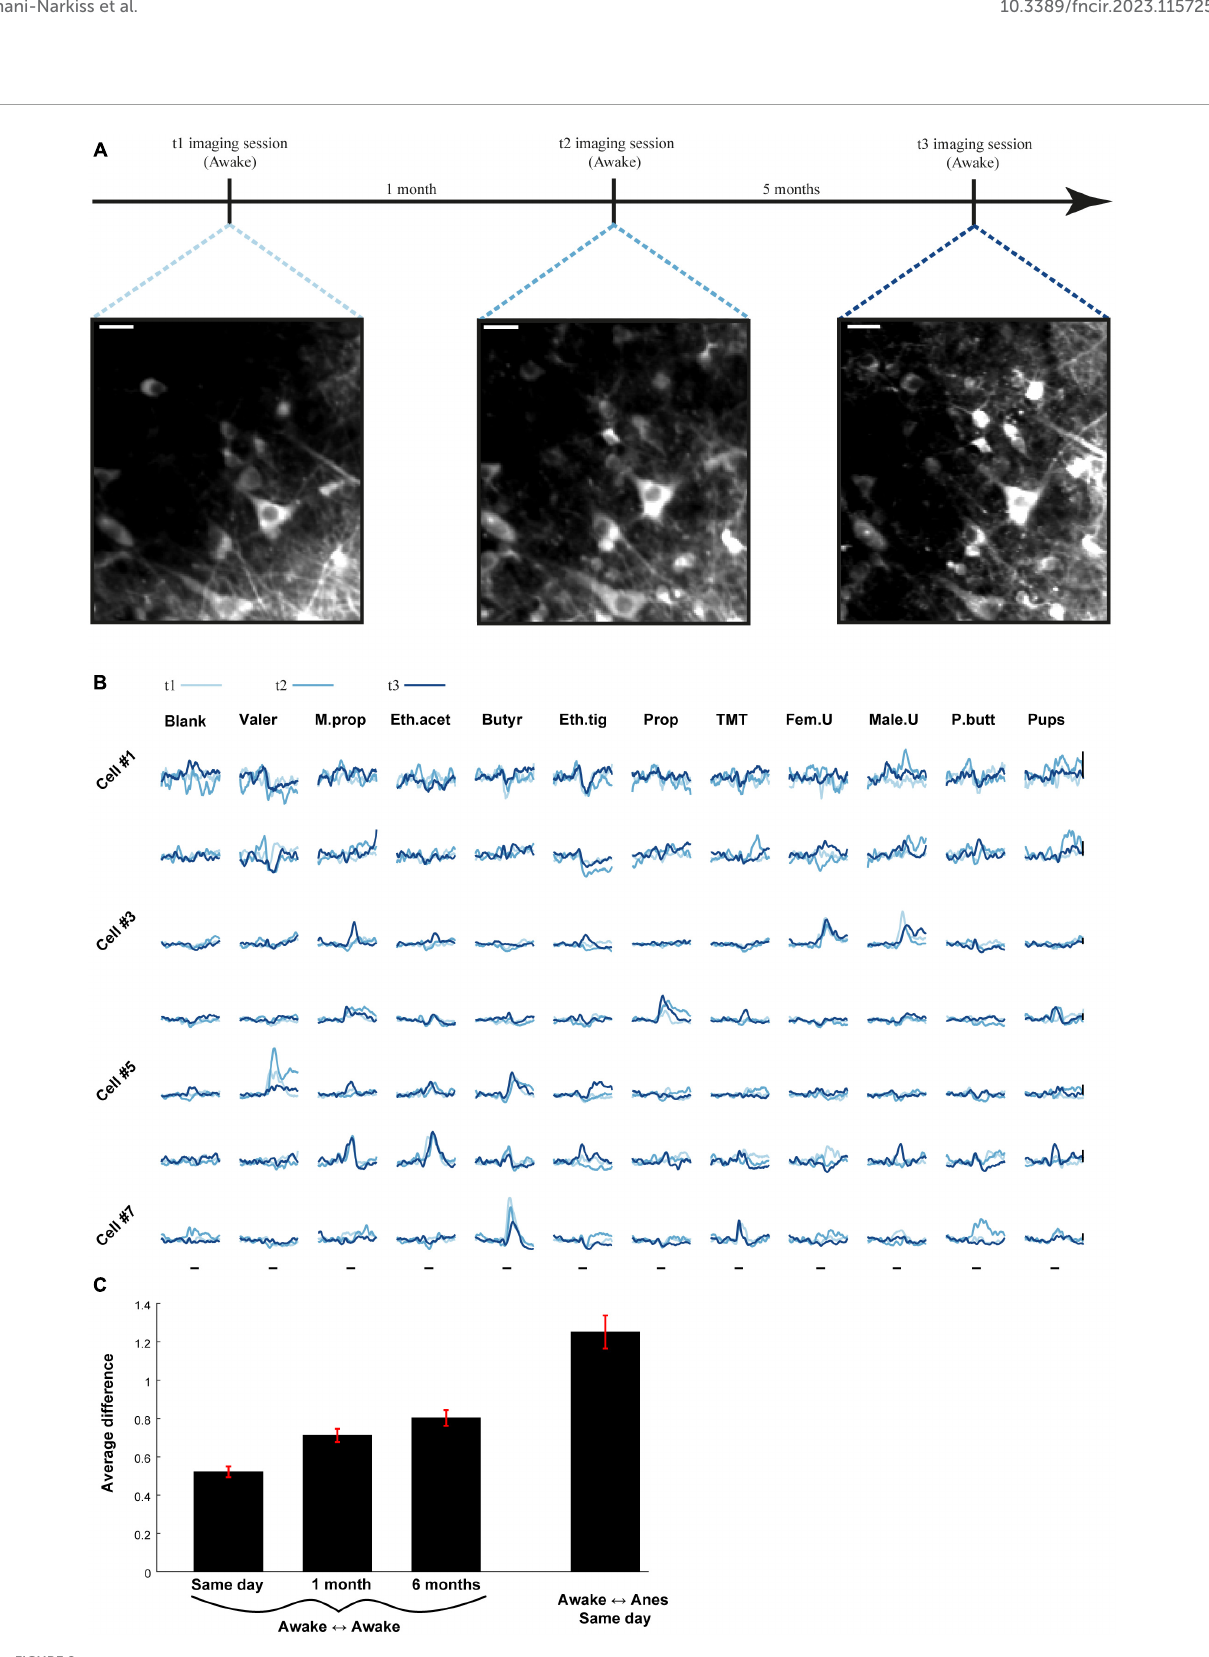
FIGURE8 Odor representations are stable over long periods of time. (A) Time-line for the experiment used to assess stability of odor representations in one example mouse over 6 months. Two-photon micrographs of mitral cell (MC) imaged 6 months apart. Scale bar = 25 um. (B) Examples of odor-evoked calcium transients from seven MCs at three time points, spaced up to 6 months apart. Traces are averaged over five repetitions. Scale bar- vertical black line, 30% dF/F. Odor stimulus is denoted by a black line – 2 s. (C) The average difference between all cell-odor pairs recorded on the same day, 1 month apart and 6 months apart (three left bars). The difference between different states recorded on the same day (right bar). Awake to anesthetized recording was conducted between imaging